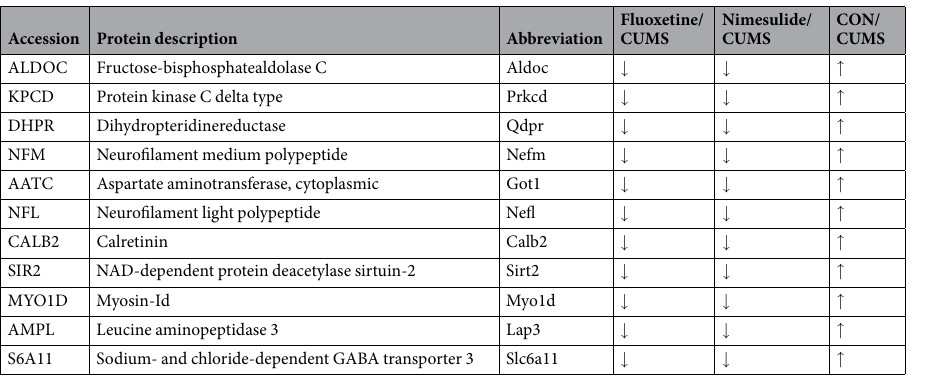
Table 1. Differentially expressed proteins were downregulated in the hippocampus of CUMS rats by nimesulide.